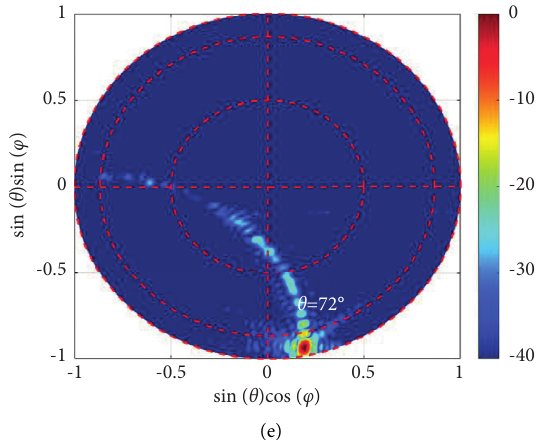
Figure 10: Simulation pattern of the VICTS antennas at 14GHz. (a) γ � 0 ° . (b) c � 10 ° . (c) c � 20 ° . (d) c � 30 ° . (e) c � 40 ° .